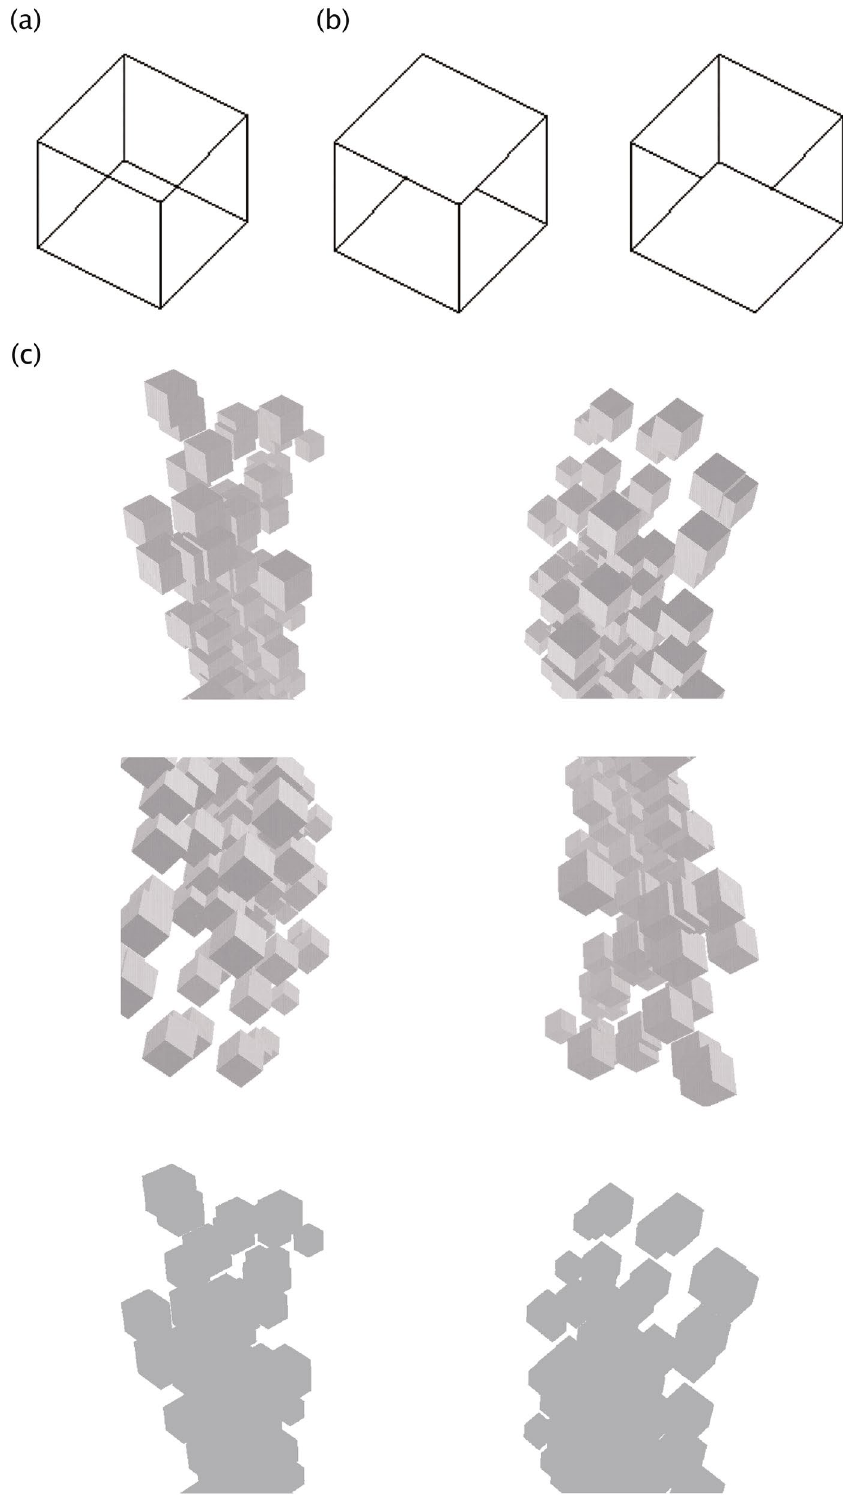
Figure 1. Stimuli used in Experiments 1 and 2. (a) The main stimulus: A Necker cube stimulus was used that evoked bistable perception from above and below. (b) Viewed from above (VFA) (left) and viewed from below (VFB) (right) cubes. In Experiment 1, they were presented before stimulus (a) as a cue. They were created by removing several lines from (a) to bias perception to VFA or VFB. These stimuli were the same when inverted, and stimuli properties were the same. (a,b) were drawn with white edges in the experiment. (c) Examples of background contexts used in Experiment 2. One of the three background contexts (VFA: top, VFB, middle, control; bottom) was presented around the stimulus of (a) randomly. The VFA and VFB stimuli are the same when inverted. The control stimulus was filled to have the same luminance as the average luminance of other background